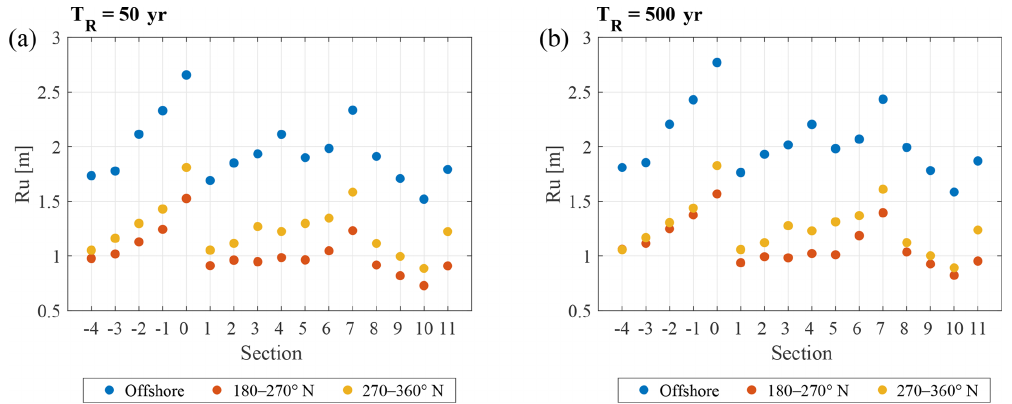
Figure 12. Comparison between run-up values for each section obtained through offshore (regional scale) and nearshore (local scale) condi- tions: (a) 50-year return period; (b) 500-year return